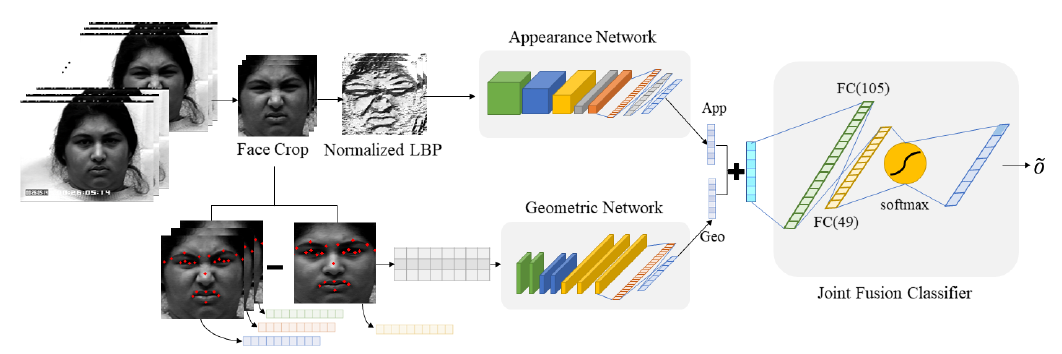
Figure 2. The overall structure of the proposed facial expression recognition